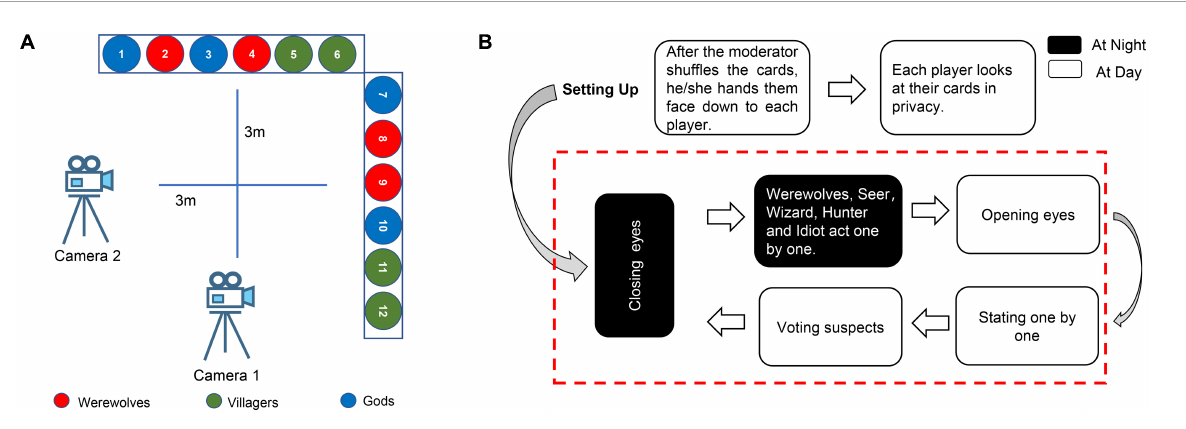
FIGURE1 (A) The layout of the recording room. Two cameras record the entire game process. The 12 undergraduates or 6–8 addicts sit in front of the camera. Each camera separately captures six undergraduates (three or four addicts). (B) The process of one game round. The night and day are looped until one game round had